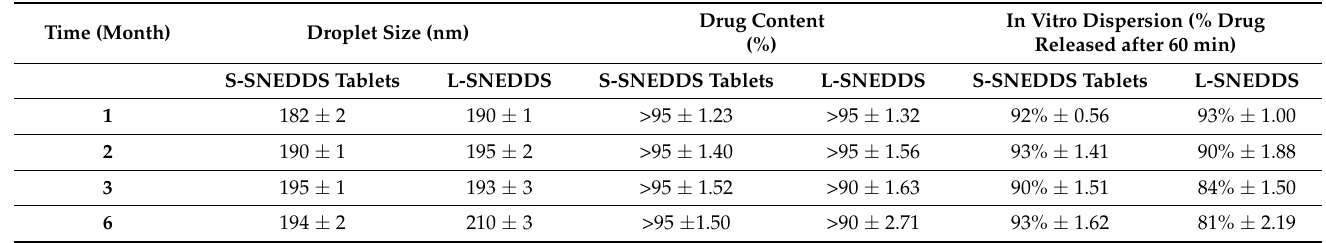
Table 4. Results of stability studies of S-SNEDDS tablets and L-SNEDDS after 1, 2, 3 and 6 months at 40 ± 2 ◦ C/75 ± 5% RH. The results are presented as mean ± SD.